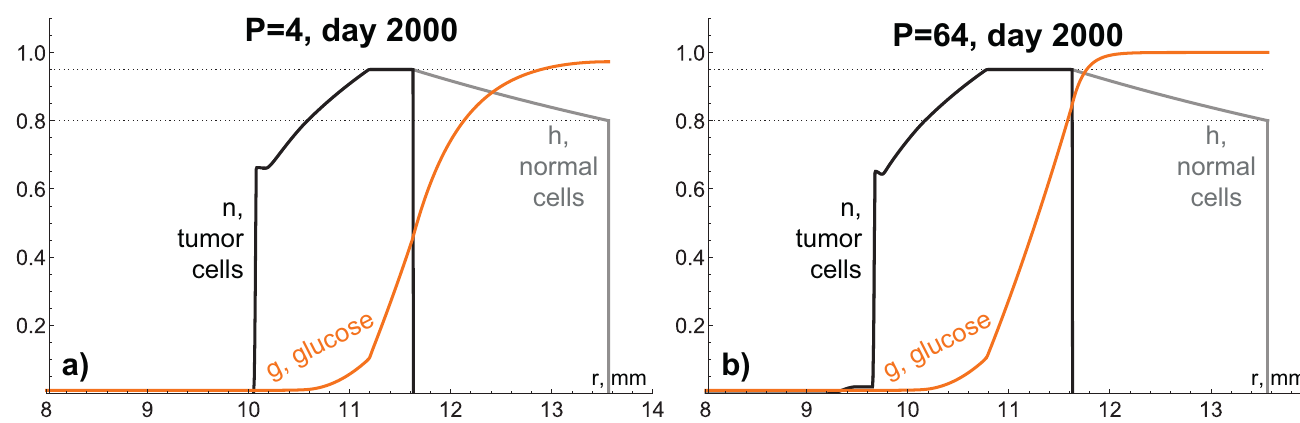
Figure 10. Distributions of the variables of the tumor growth model, governed by the system of Equation (6), produced by numerical simulations under tissue hydraulic conductivity K / µ = 0.003 and nutrient supply levels ( a ) P = 4 and ( b ) P = 64 on the 2000th days of tumor growth. In both cases, the tumor core is filled with fluid. Dotted lines denote the values of initial fraction of cells c 0 and critical fraction of cells c cr , at which cell proliferation ceases.